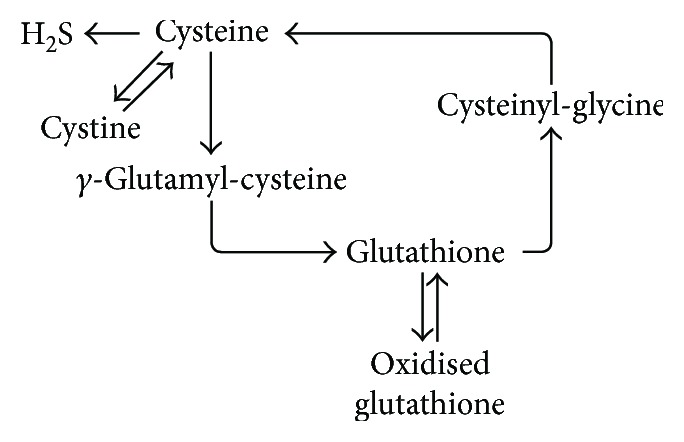
Simplified schematic representation of the main metabolic pathways involved in the production and degradation of glutathione in mammalian tissues.